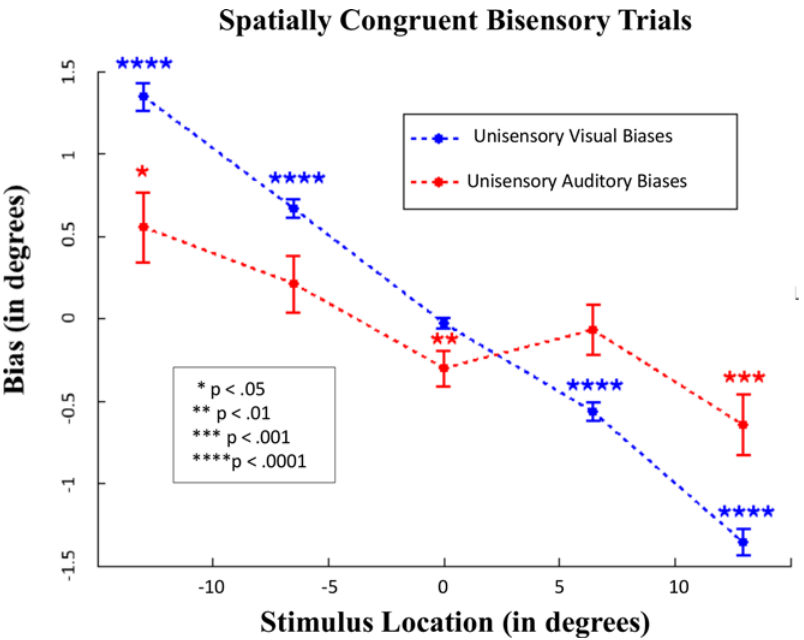
Fig 4. Visual and auditory biases on spatially congruent bisensory trials. First, each subject ’ s average bias (over 15 trials) was computed for each of the five locations. Then, the mean across 384 subjects was calculated. Error bars represent standard error of the mean across subjects ’